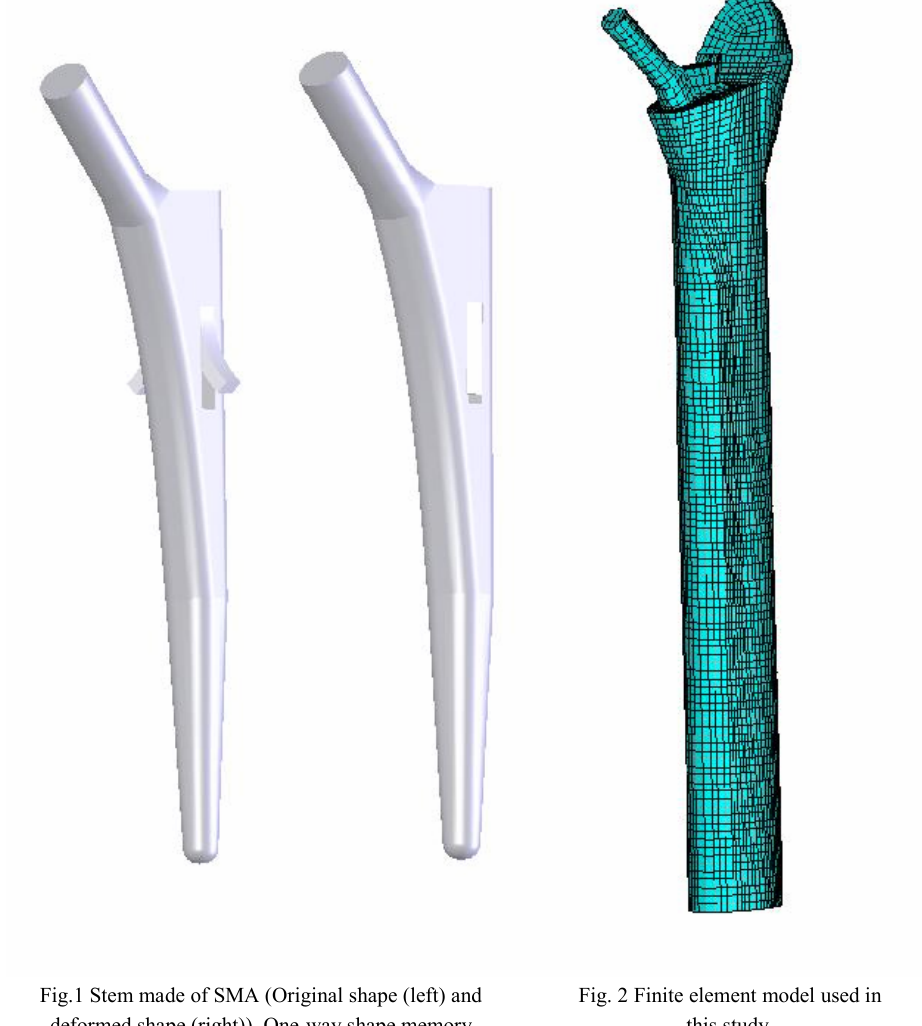
Fig. 2 Finite element model used in this